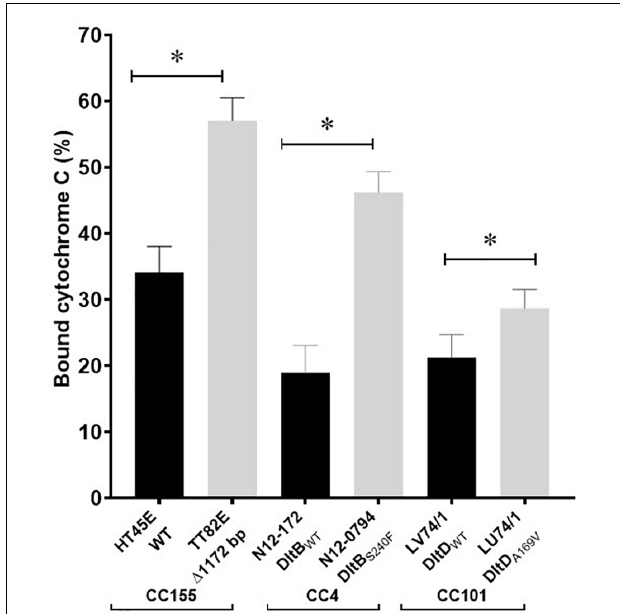
FIGURE 11 | Strains with natural dlt operon mutations have an increased cell surface negative charge consistent with impaired Dlt system function. Cytochrome c binding comparison of high nisin sensitivity dlt operon mutant strains TT82E, N12-0794, and LU74/1 and their corresponding non-mutated clonal control strains (HT45E, N12-1772, and LL66/3). * P < 0.05 significant difference between the strains identified using the pairwise t -test comparison for independent